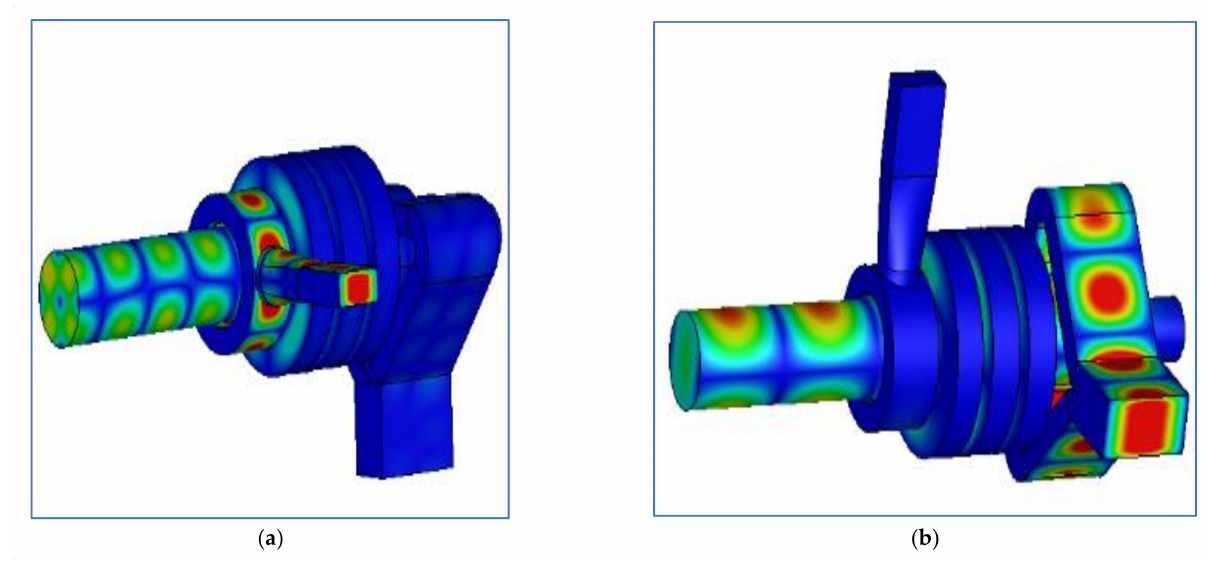
, ( b ) the output (cid:35) 1,1